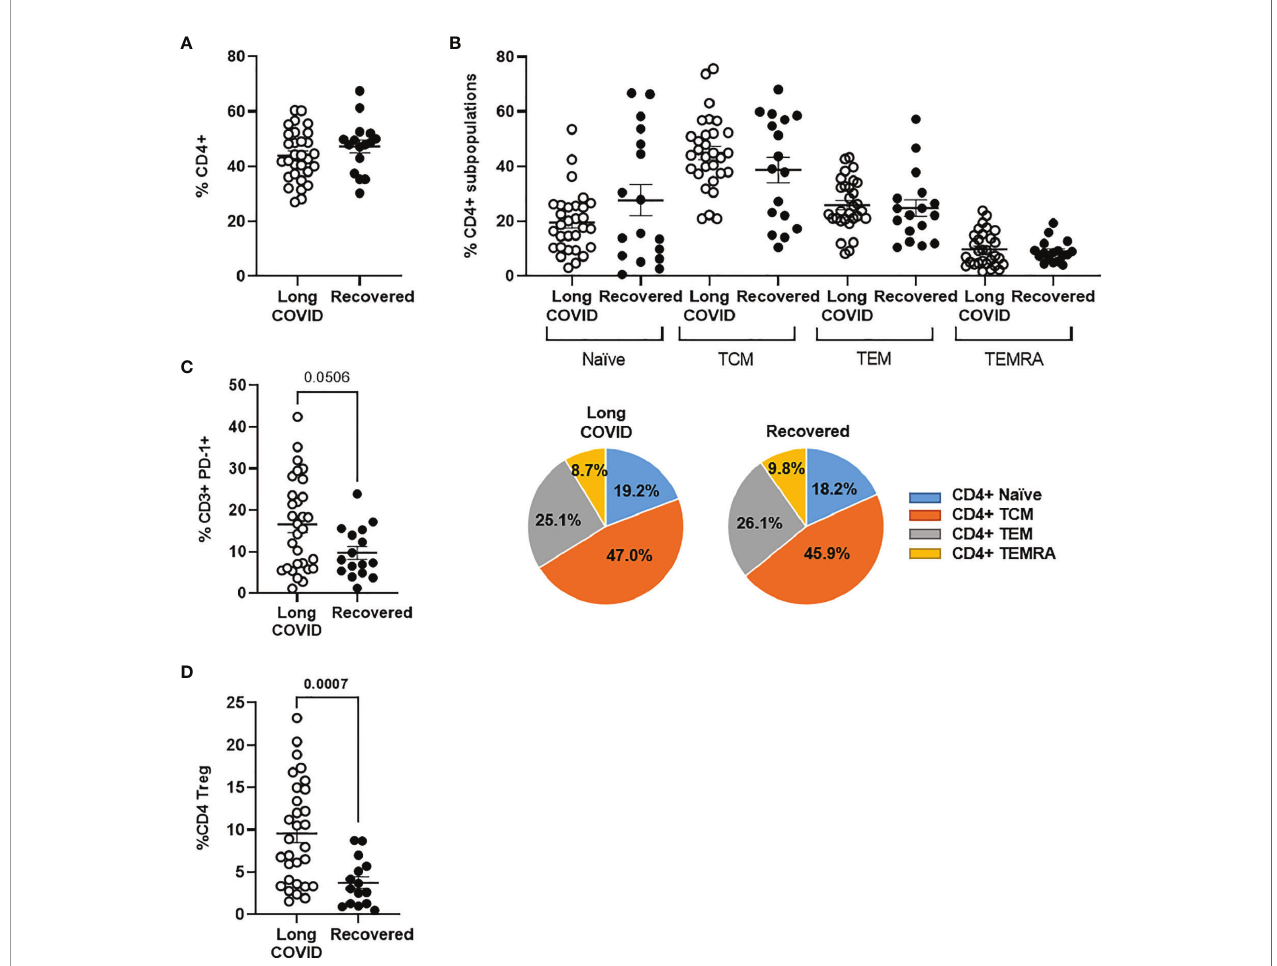
FIGURE 1 | Analysis of CD3 + and CD4 + T-cell populations in PBMCs from the Long-COVID and Recovered groups. Total levels of CD4 + T cells (A) and CD4 + T-cell memory subpopulations (B) were analyzed by fl ow cytometry. Individual data are shown in a dot plot, and mean data are shown in the pie charts. (C) The expression of the exhaustion marker PD-1 was analyzed in CD3 + T cells. (D) The levels of CD4 + Tregs were also quanti fi ed by fl ow cytometry in both groups of individuals. Each dot in the graphs corresponds to one sample, and lines represent mean ± standard error of the mean (SEM). Statistical signi fi cance was calculated using non-parametric Mann – Whitney test. PBMCs, peripheral blood mononuclear